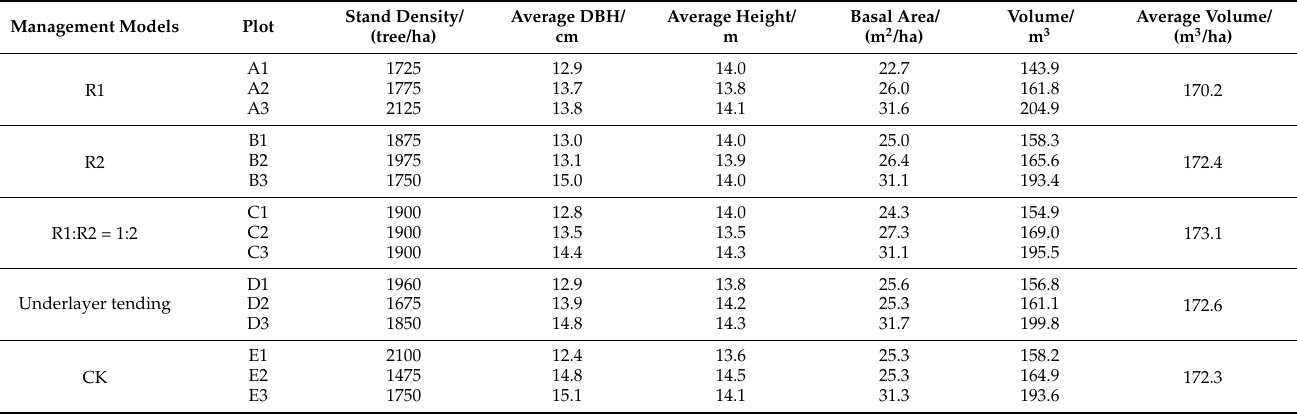
Table 2. Plot information for L. kaempferi